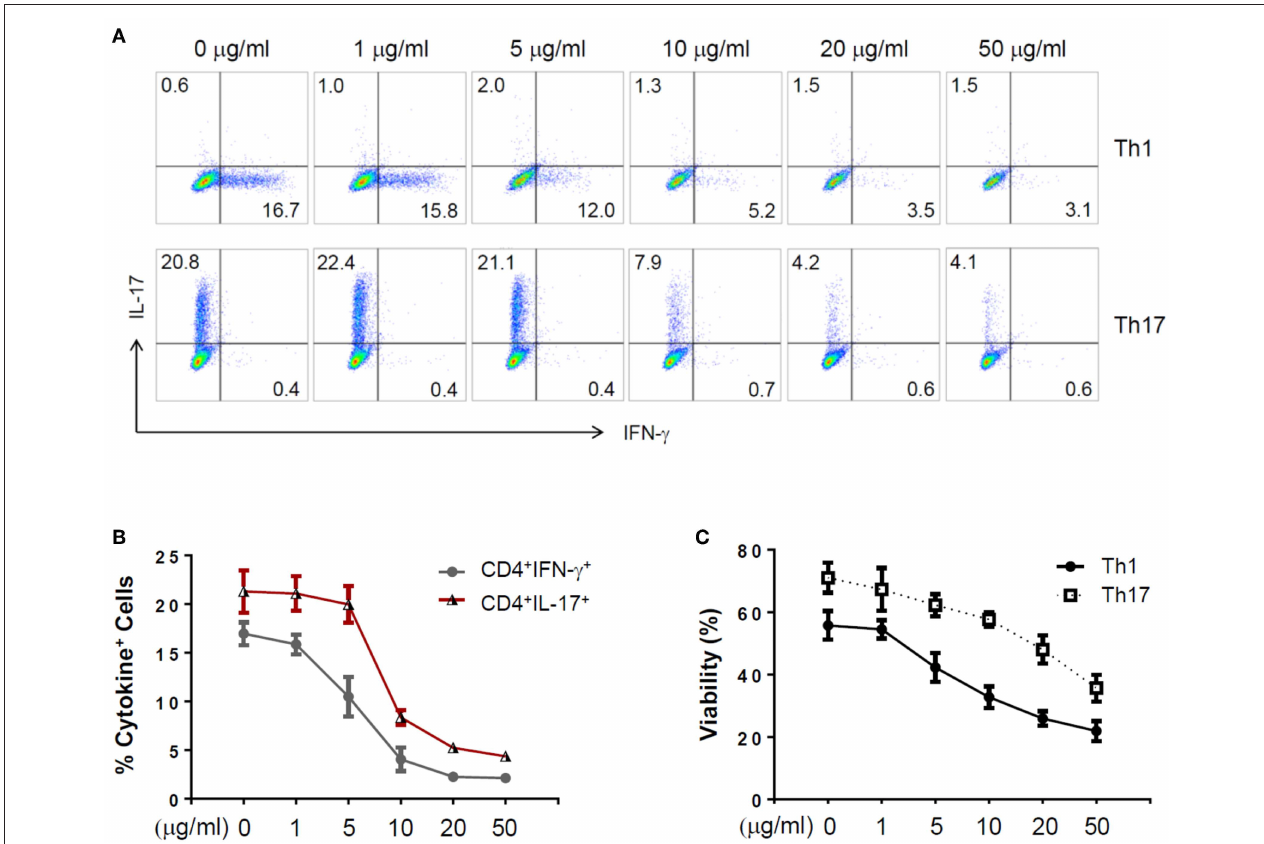
FIGURE 2 | The expression of IFN- γ and IL-17A in zebularine-treated murine Th1 and Th17 cells in vitro . (A) Representative dot plots ( N = 5) for murine Th1 and Th17 cells stained with IFN- γ and IL-17A. (B) The percentages of IFN- γ + and IL-17 + cells in zebularine-treated murine CD4 + T cells. (C) Viability of murine Th1 and Th17 cells treated with different doses of zebularine. Means ± SD are